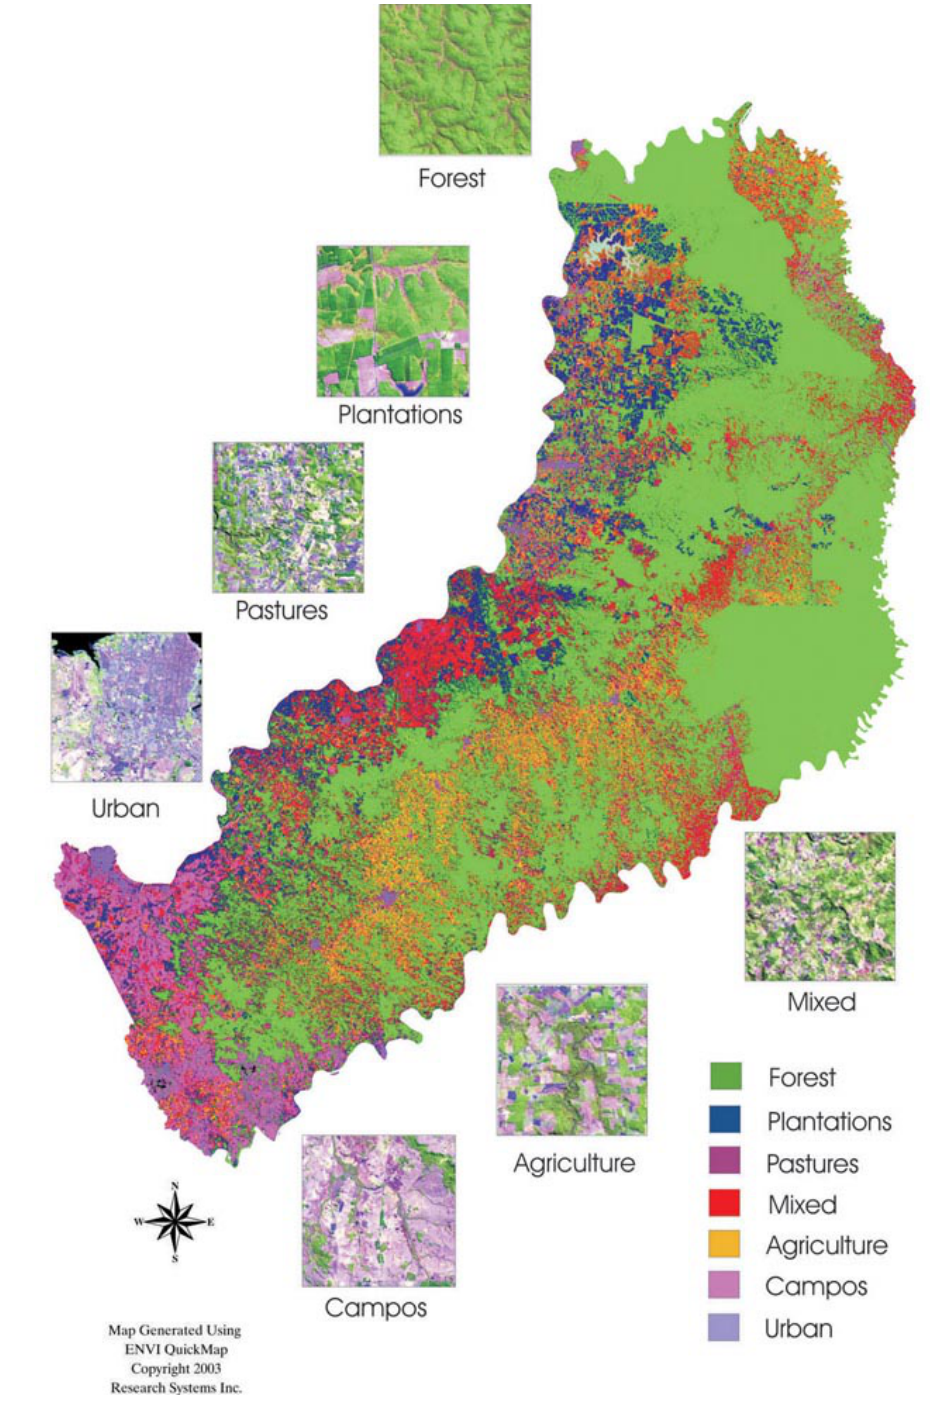
Fig. 2. The 2006 classification map of Misiones, with examples of the different land-use